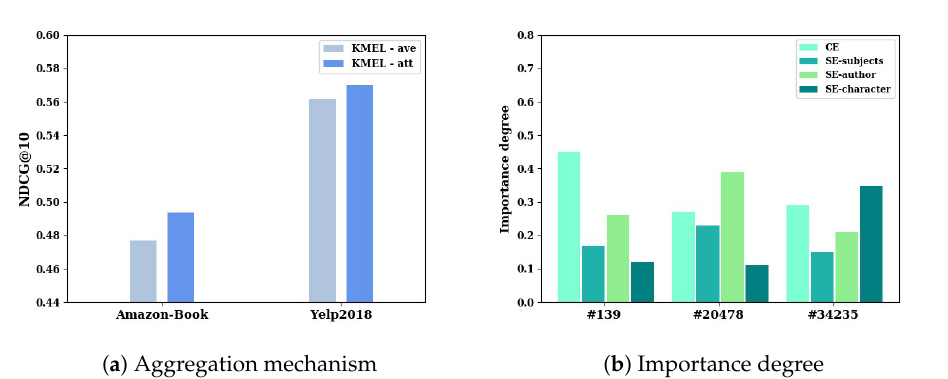
Figure 4. Performance comparison on aggregation by NDCG@10 with ( a ) linear (ave) and target- aware (att) aggregation mechanisms, and ( b ) importance degree of collaborative embeddings (CE) and semantic embeddings of semantics (SE-character, SE-author, SE-subjects) for users #139, #20478 and #34235 from Amazon-Book